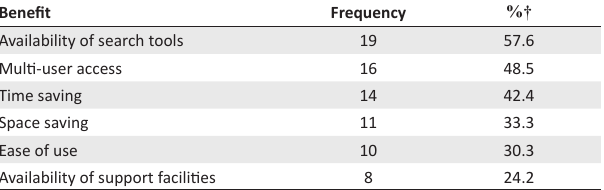
TABLE 2: Benefits motivating the use of e-resources by postgraduate students.